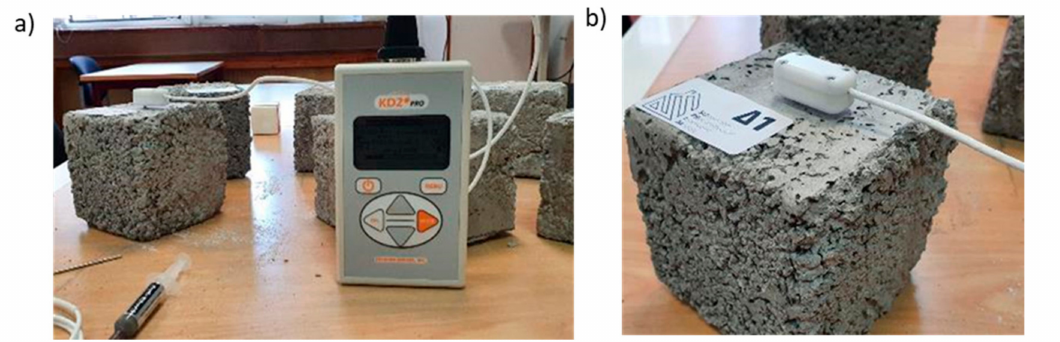
Figure 2. ( a ) experimental device and samples for the thermal conductivity measurements and ( b ) TR-1 sensor installation into the material.